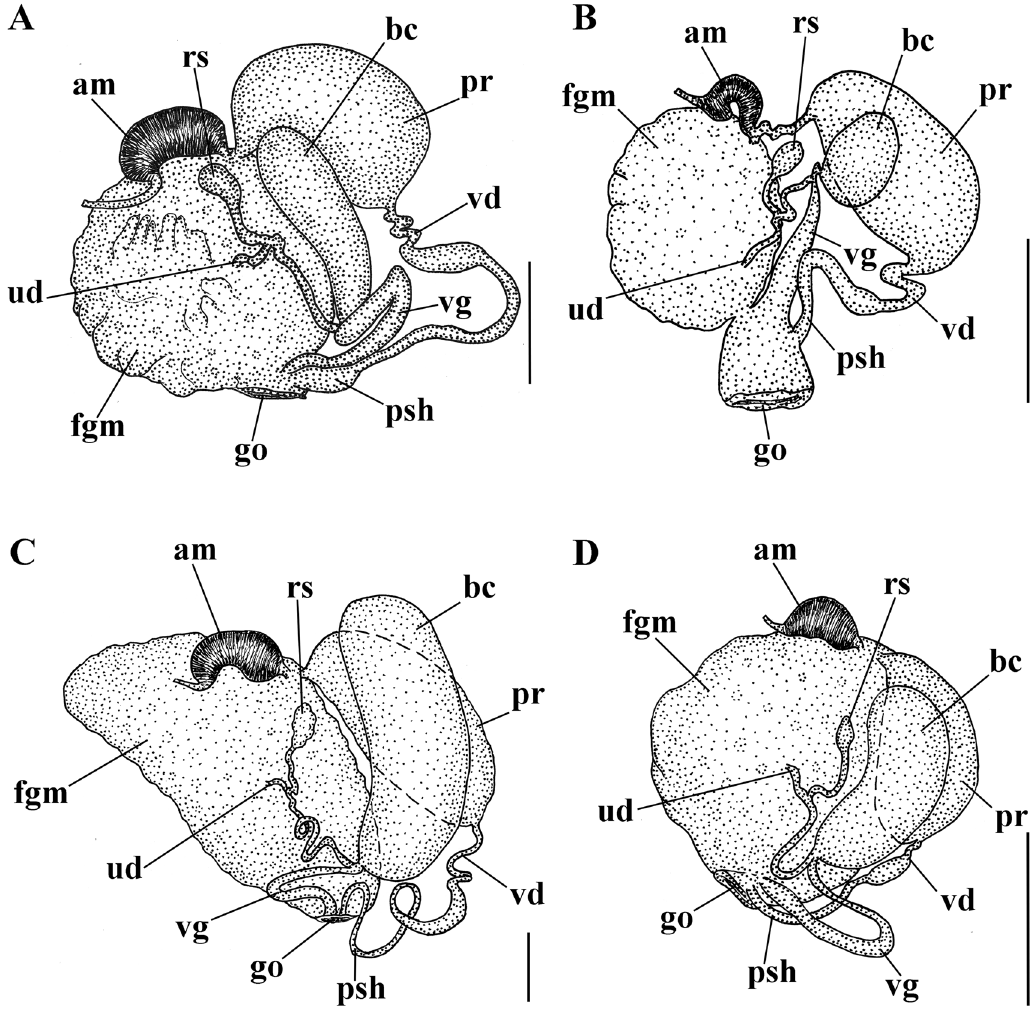
Figure 6. Schemes of the reproductive systems. ( A ) Polycera quadrilineata . ( B ) P. capitata. ( C ) P. faeroensis. ( D ) P . kernowensis sp. nov. am ampulla, bc bursa copulatrix, fgm female gland mass, go genital opening, pr prostate, psh penial sheath, rs receptaculum seminis, ud uterine duct, vd vas deferens, vg vagina. Scale bars: 1